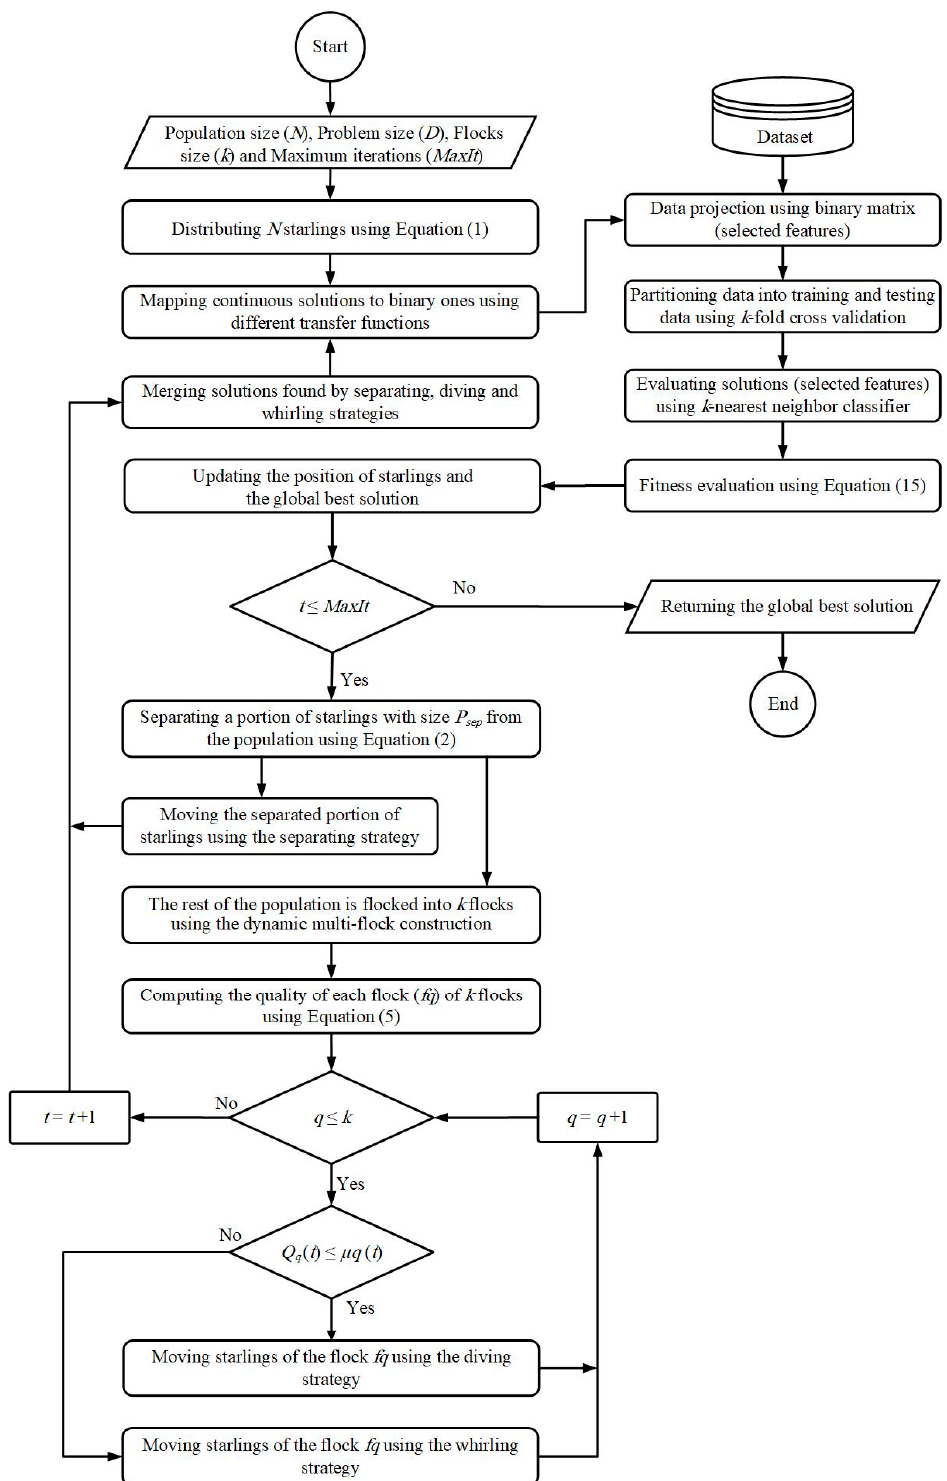
Figure 3. Flowchart of the proposed BSMO algorithm.